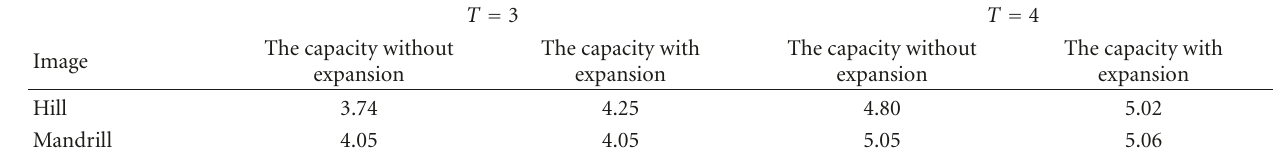
Table 3: Embedding capacity in terms of bit per pixel ( bpp ) before and after clustering. T = 3